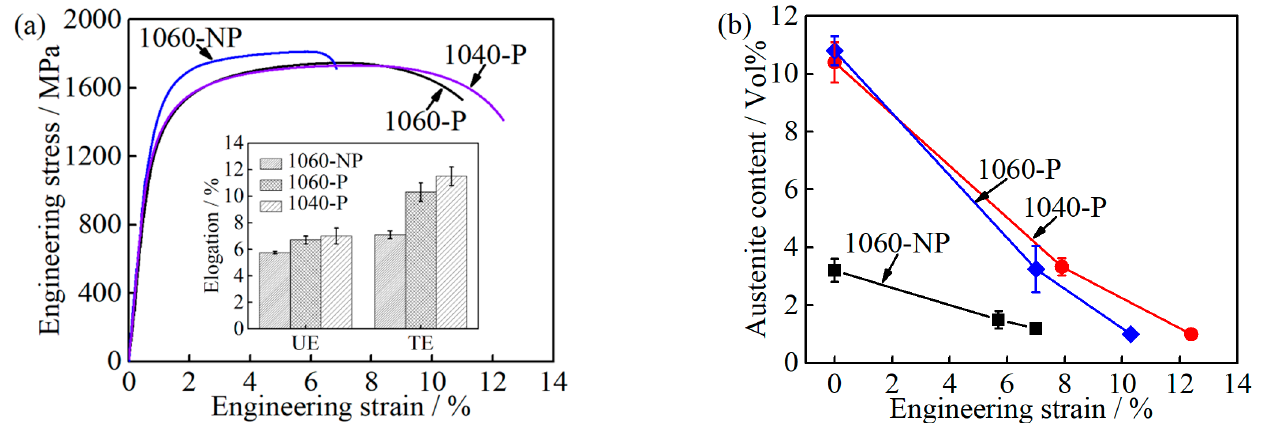
Figure 12. Comparison among 1060-NP, 1060-P and 1040-P ( a ) engineering stress-strain curves and elongation; and ( b ) austenite content at a different engineering strain.